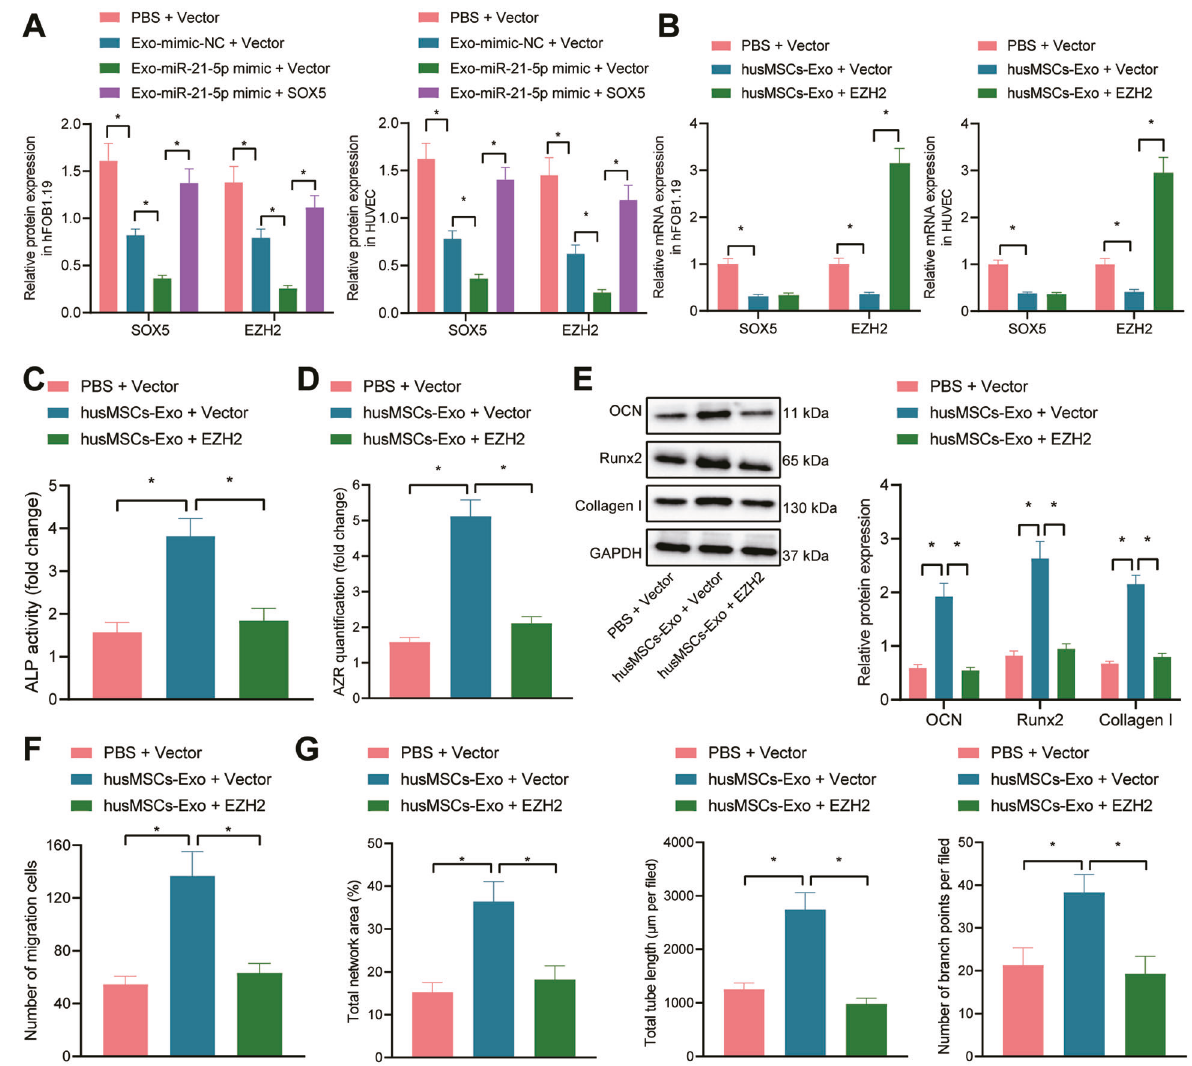
Fig. 4 hucMSC-Exos enhance HUVEC angiogenesis and hFOB1.19 cell osteogenesis by inhibiting the expression of EZH2. A Immunoblotting analysis of SOX5 and EZH2 protein levels in hFOB1.19 cells and HUVECs; B SOX5 and EZH2 mRNA expression in hFOB1.19 cells and HUVECs determined with RT-qPCR; C quantitative analysis of ALP activity of hFOB1.19 cells; D quantitative analysis of calcium deposition of hFOB1.19 cells by alizarin red S staining; E Immunoblotting analysis of the expression of osteogenesis-related markers (OCN, Runx2 and Collagen I) in hFOB1.19 cells; F the migration of HUVECs determined with Transwell assay; G the tube-forming ability of HUVECs with total network area, total length, and the number of branch points determined with capillary-like tube formation assay. Cell experiment was repeated three times independently. * p <